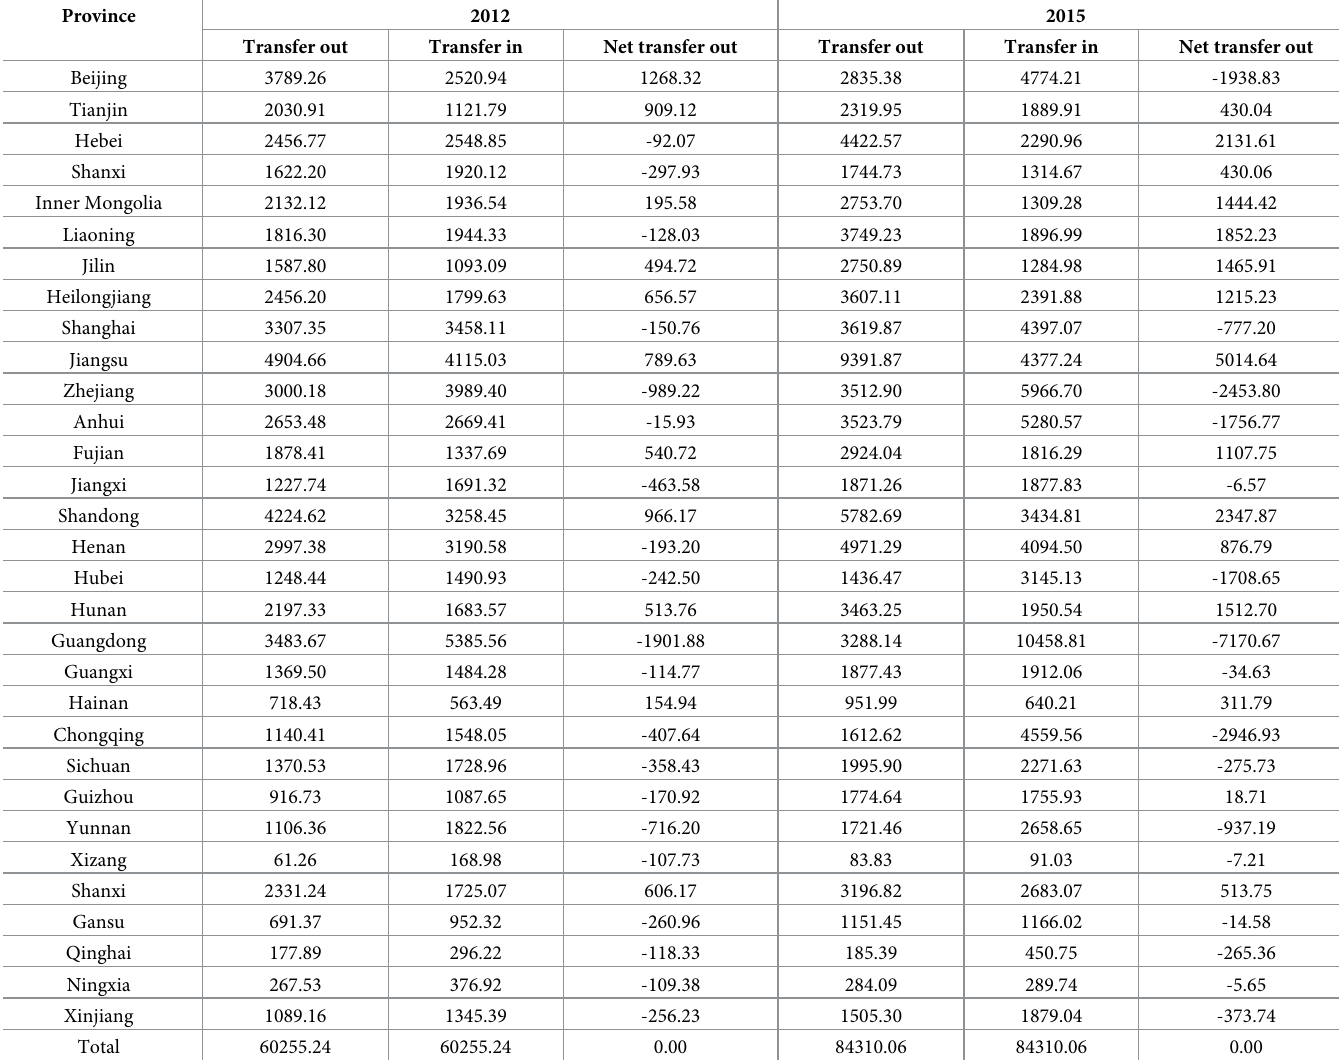
Table 5. Value-added trade volume of each province in 2012 and 2015 (unit: billion yuan).